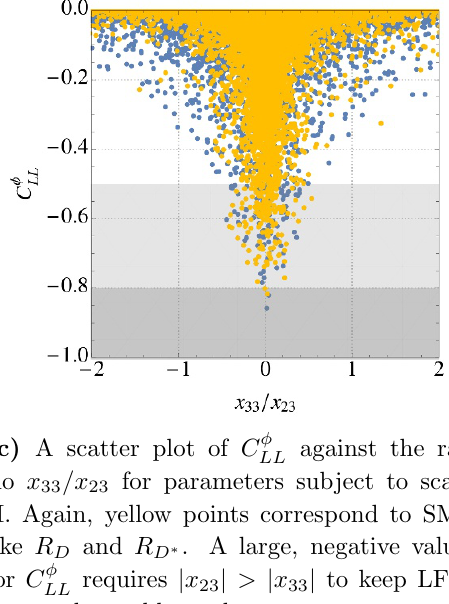
Figure 9. The key results probing the extent to which the model can explain the tensions in . Signi(cid:12)cant improvement from the SM is possible for leptoquark masses between 3 and R K ( (cid:3) ) 5 TeV, j x 23 j > j x 33 j and suppressed y 2 . The grey areas in (b) and (c) are the 1 and 2 (cid:27) allowed i regions for R K ( (cid:3) )